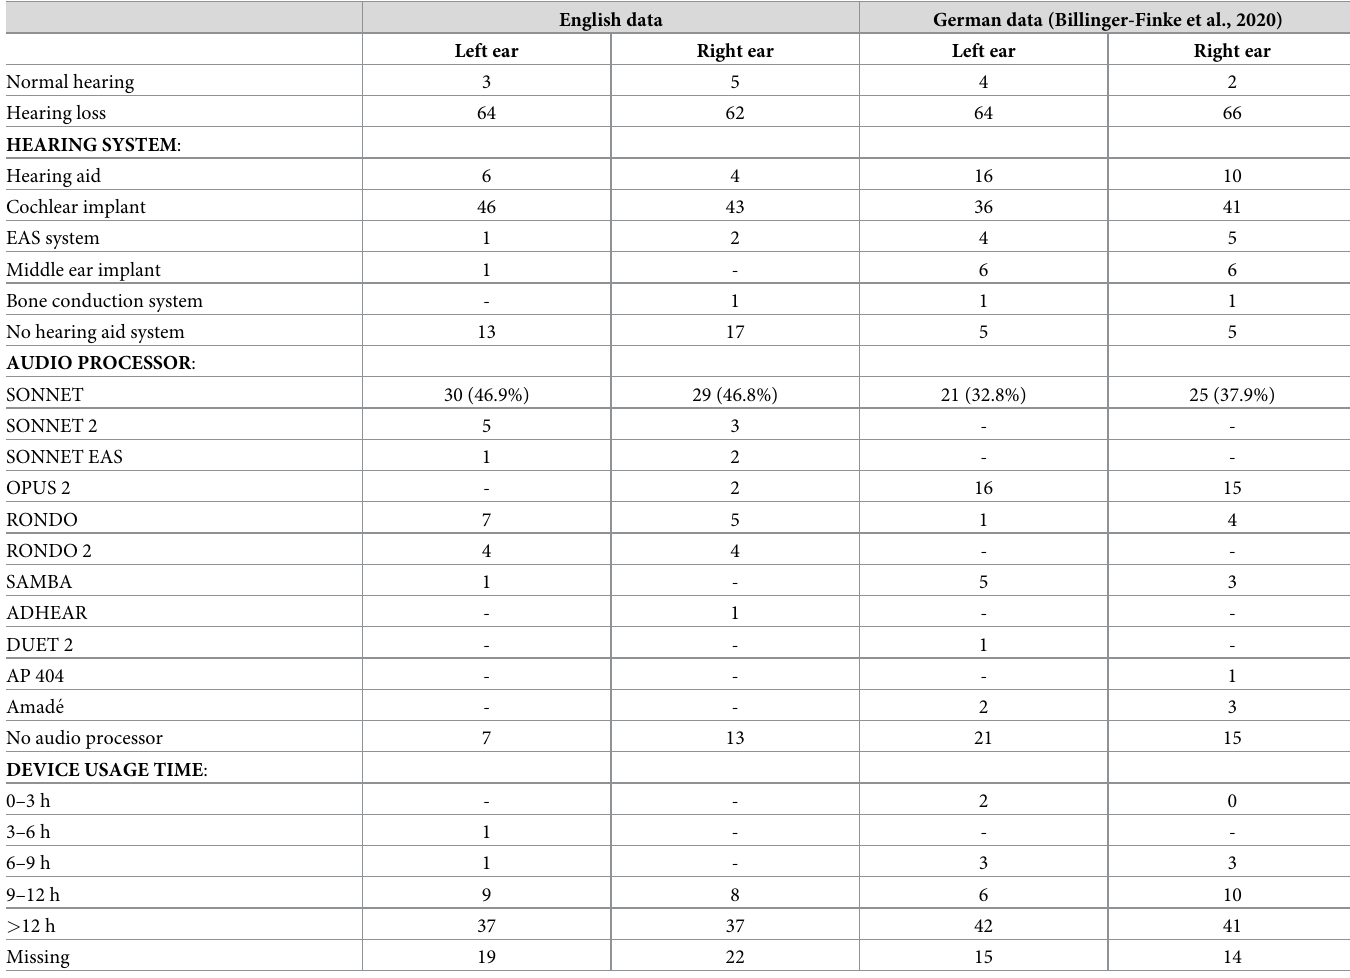
Table 1. Demographic information comparing the current English dataset to the German dataset (Billinger-Finke et al., 2020), including the hearing systems and audio processors used, along with the device usage times, per ear. EAS = electric acoustic